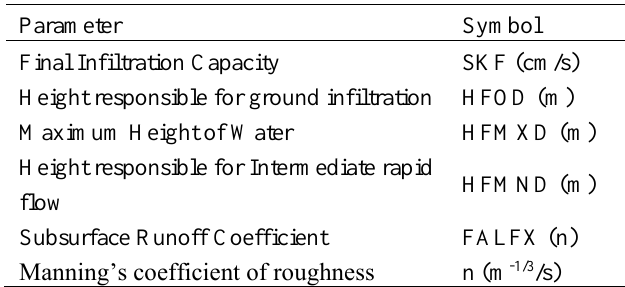
Surface Layer Tank Parameters Included In Sensitivity